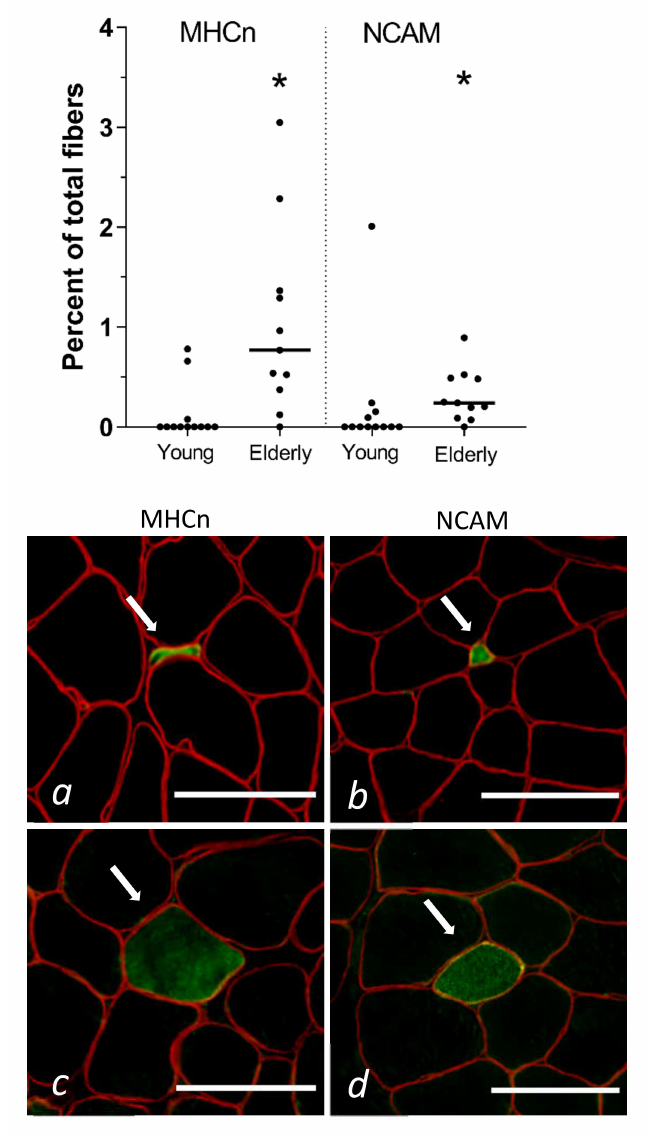
Figure 2. Muscle fibres positive for MHCn or NCAM in biopsy cross-sections from 12 young and 11 elderly women. Only the control leg is shown. Individual values are presented with the median (horizontal line). Panels show examples of small MHCn ( a ) and NCAM ( b ), and large MHCn ( c ) and NCAM ( d ) fibres (arrows). Positive fibres are green, dystrophin, red. * p < 0.05 vs. young. MHCn, neonatal myosin heavy chain; NCAM, neural cell adhesion molecule. Scale bars = 100 µ